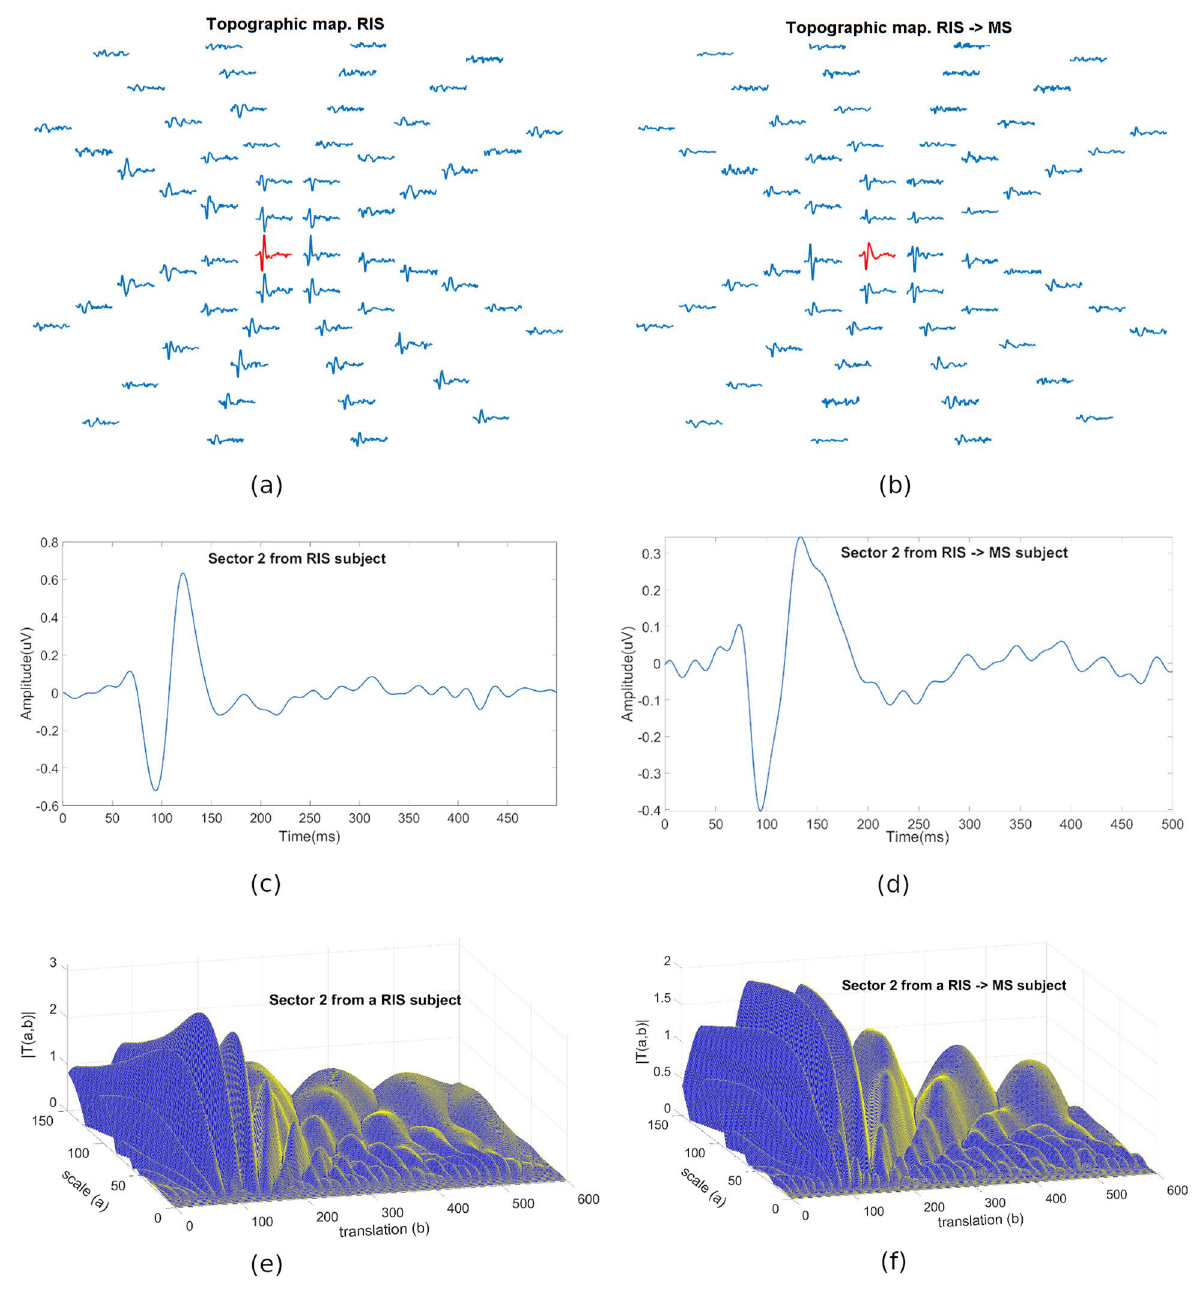
Figure 2. Multi-phase graphical representation of the method implemented. ( a ) mfVEP arrays of an RIS_non_ conv patient. ( b ) mfVEP arrays of an RIS_conv patient. ( c ) X(t) signal in the sector marked in red in ( a ). ( d ) X(t) signal in the sector marked in red in ( b ). ( e ) CWT modulus of the signal represented in ( c ). ( f ) CWT modulus of the signal represented in ( d ). These images were generated using Matlab (Version: R2018b, Url: https ://www. mathw orks.com/produ cts/matla b.html.